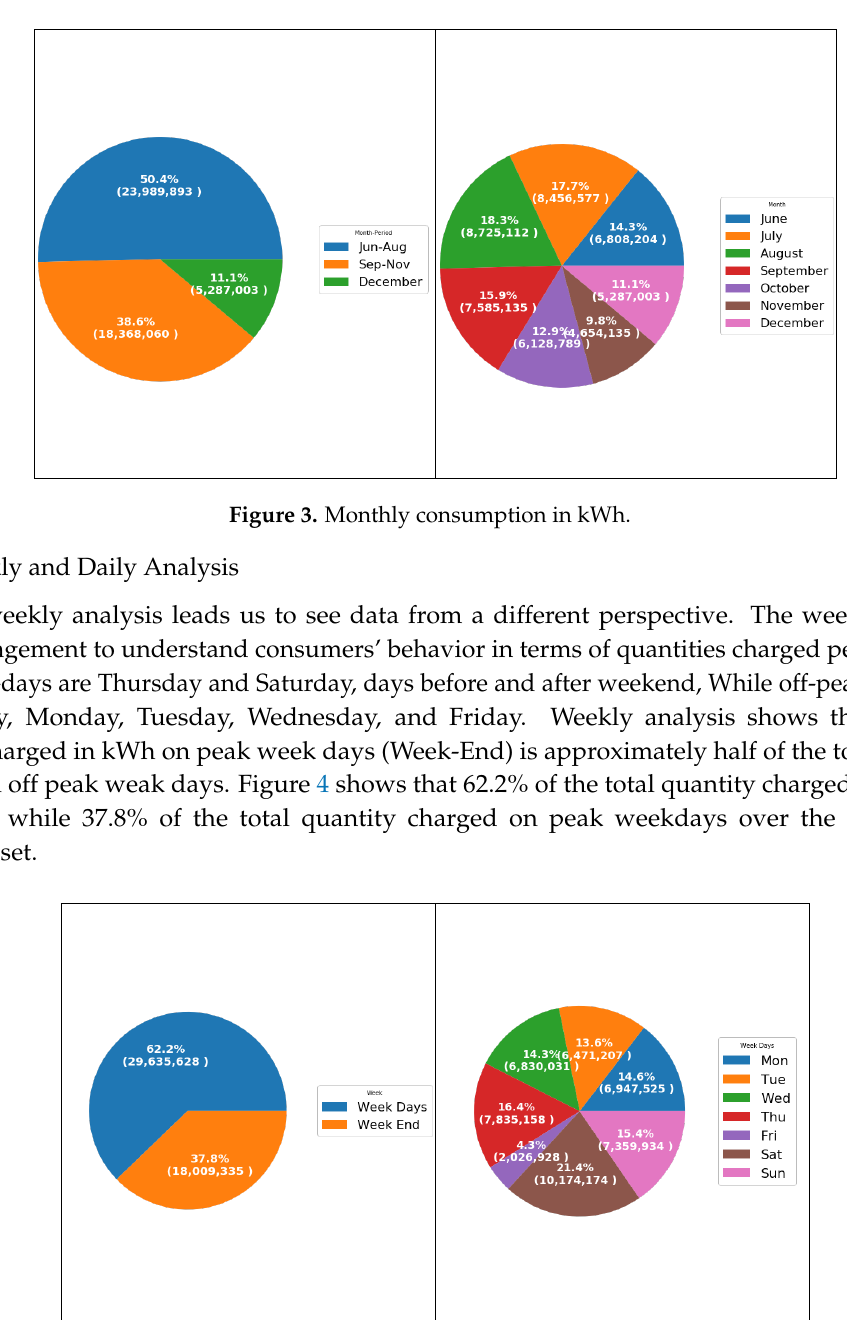
Figure 4. Electricity quantity charged in kWh weekly and